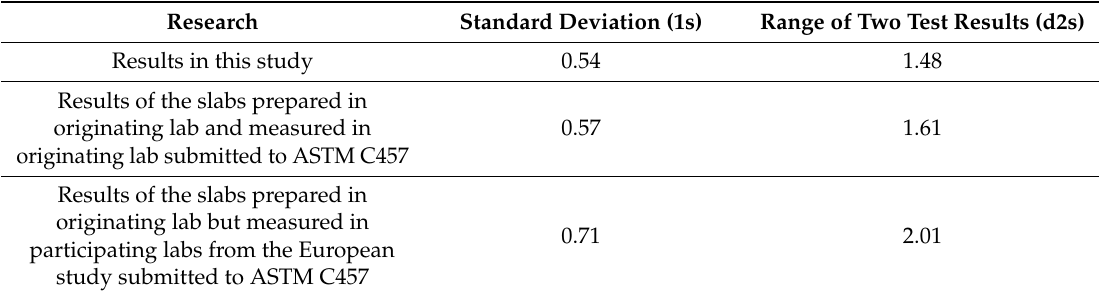
Table 4. Comparison of the average precision data of the air content (%) between this study and the European study submitted to ASTM C457 [8].